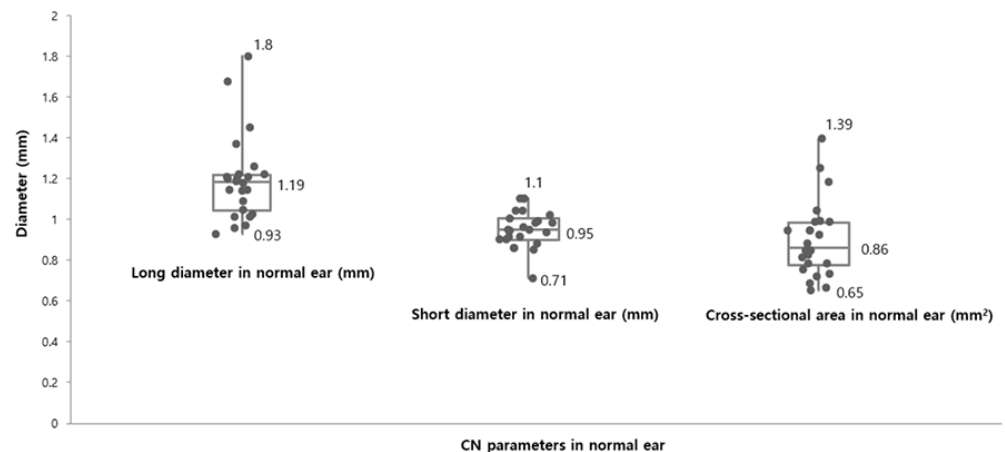
Figure 2. Cochlear nerve size parameters in the unaffected ears. The mean of long diameter (Ld, mm) and short diameter (Sd, mm) were 1.19 ± 0.13 mm (range: 0.93 mm–1.8 mm) and 0.95 ± 0.16 mm (range: 0.71 mm–1.1 mm), respectively. The cross-sectional area (CSA, mm 2) in normal ears ranged from 0.65 mm 2 to 1.39 mm 2 and the mean of the CSA were measured 0.86 ± 0.18 mm 2 as present. The CN status was classified in accordance with the presence or the size of CN: (1) ‘absent CN’ refers to the a parasagittal oblique image with no visible CN; (2) ‘small CN’ is defined as when CN of the affected ear is optically smaller than FN and the values of Ld, Sd, and CSA were all less than those corresponding to one standard deviation from the mean of the unaffected ear (Ld < 1.06 mm; Sd < 0.79 mm; CSA < 0.71 mm 2 ); (3) ‘indeterminate CN’ is defined as when CN is optically similar to ‘absent CN’, ’small CN’, and ‘indeterminate CN’ as defined according to their criteria described